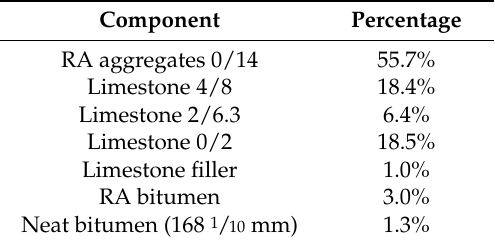
Table 2. Composition of the AC14 mixture.